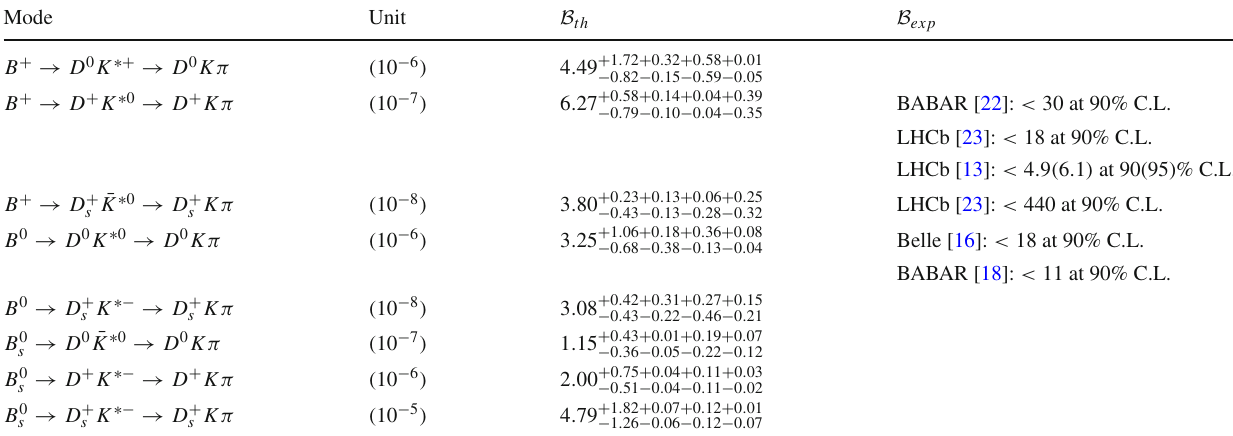
Table 2 The PQCD predictions for the branching ratios of the CKM suppressed B ( s ) → D ( s ) K ∗ → D ( s ) K π decays in the quasi-two-body framework together with experimental